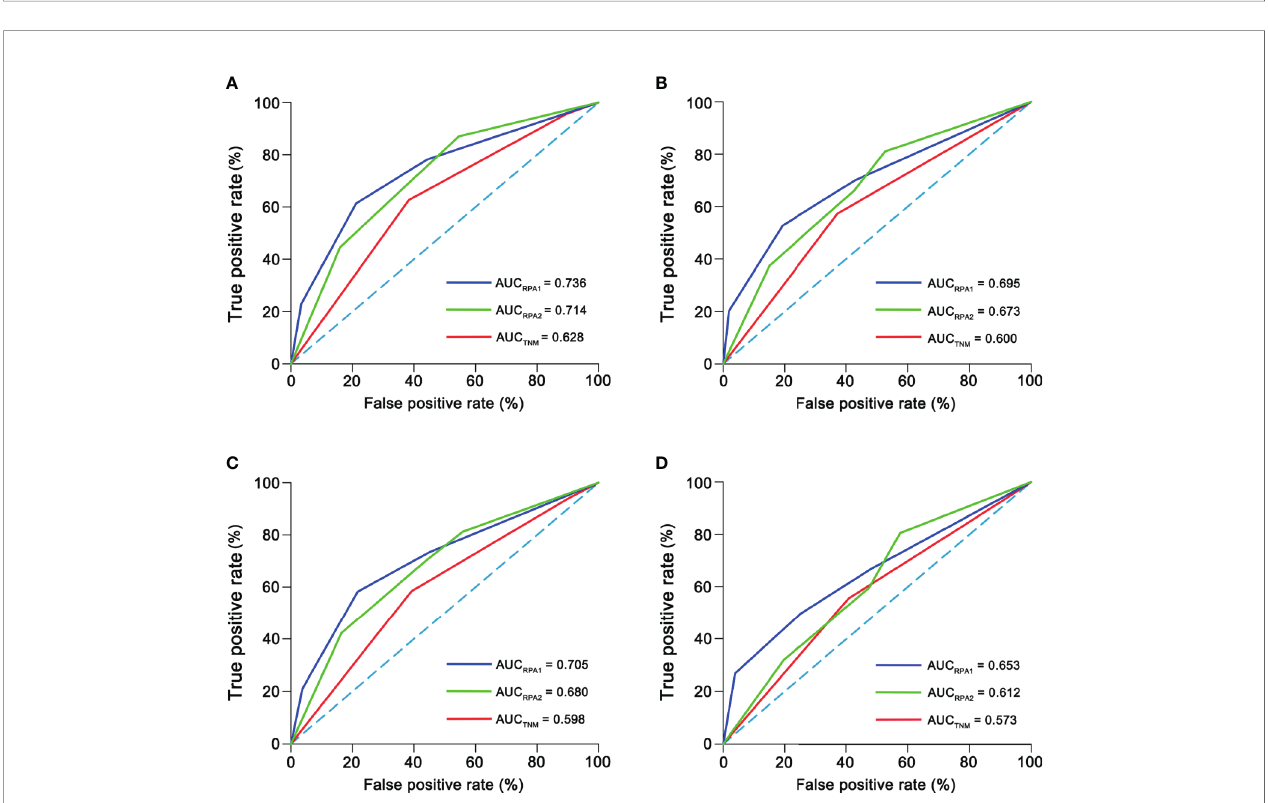
FIGURE 5 | Time-independent ROCs of different staging. (A) 5-year overall survival; (B) 5-year disease-free survival; (C) 5-year distant failure-free survival; (D) 5-year locoregional failure-free survival. ROC, receiver operating curve; AUC, area under